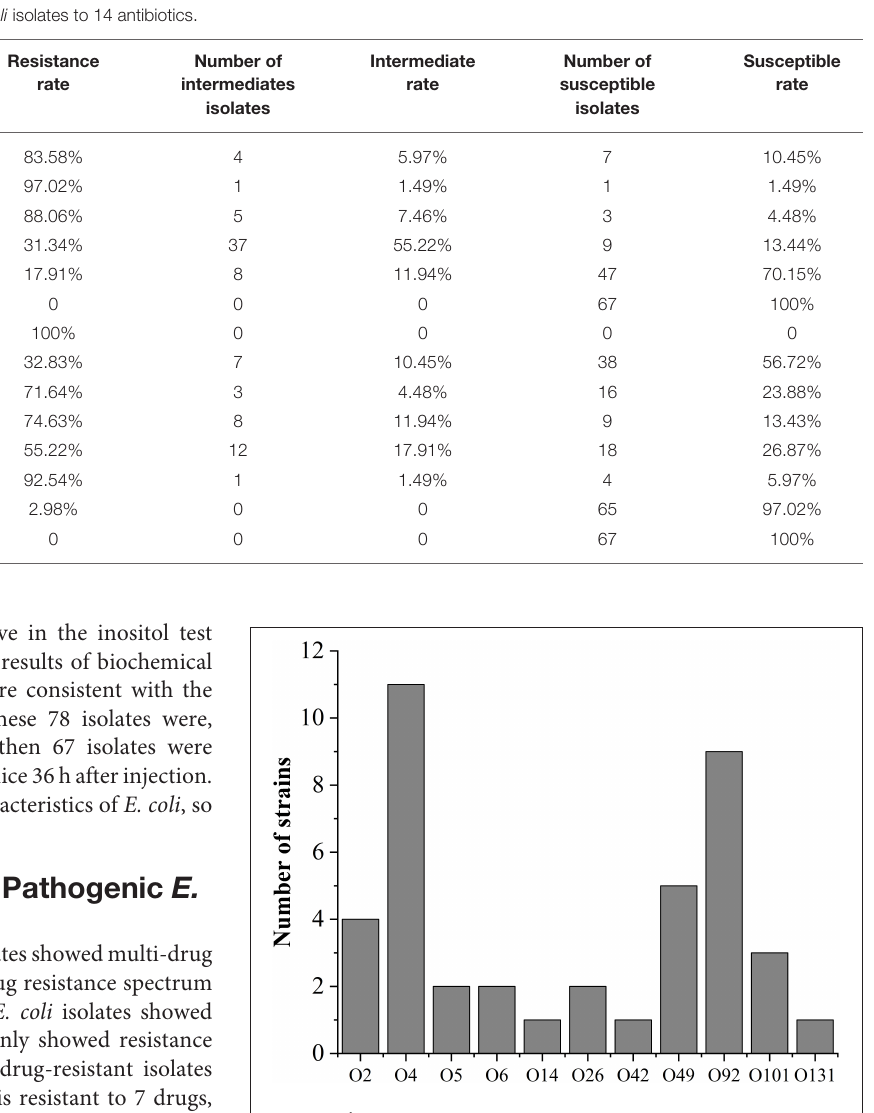
Number of resistant isolates